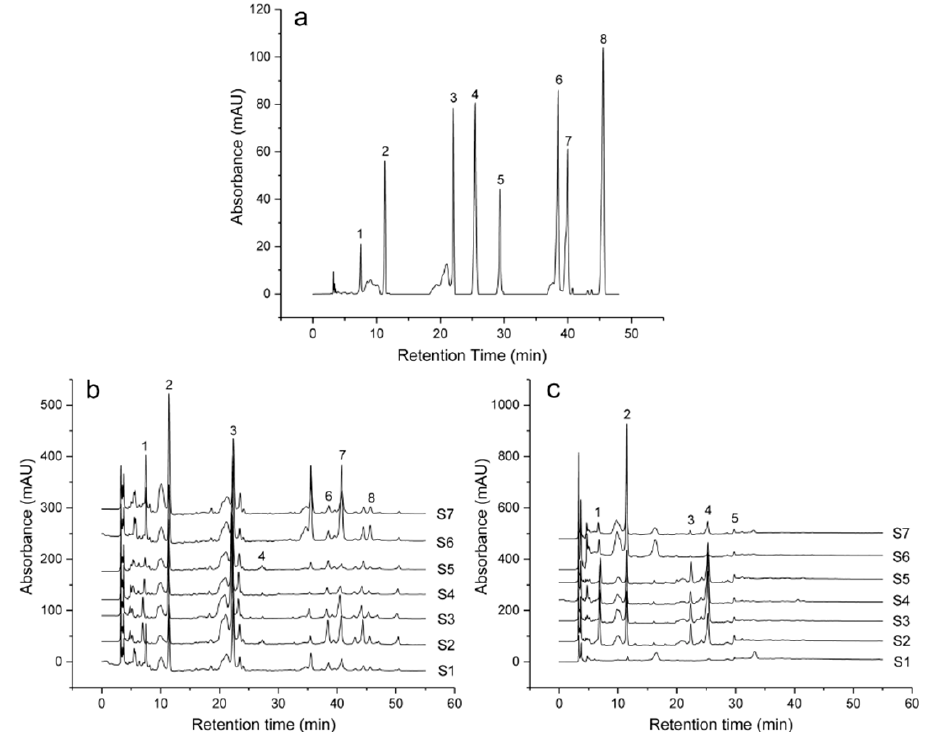
Figure 1. HPLC analysis of the eight mixed standards ( a ), and the HPLC fingerprinting profiles for leaf ( b ) and bark ( c ) of different E. ulmoides varieties. ( a ) The peaks 1–8 and the wavelength were aucubin (208 nm), geniposidic acid (238 nm), chlorogenic acid (238 nm), geniposide (238 nm), pinoresinol diglucoside (238 nm), rutin (254 nm), hyperoside (254 nm), and astragalin (254 nm), respectively.